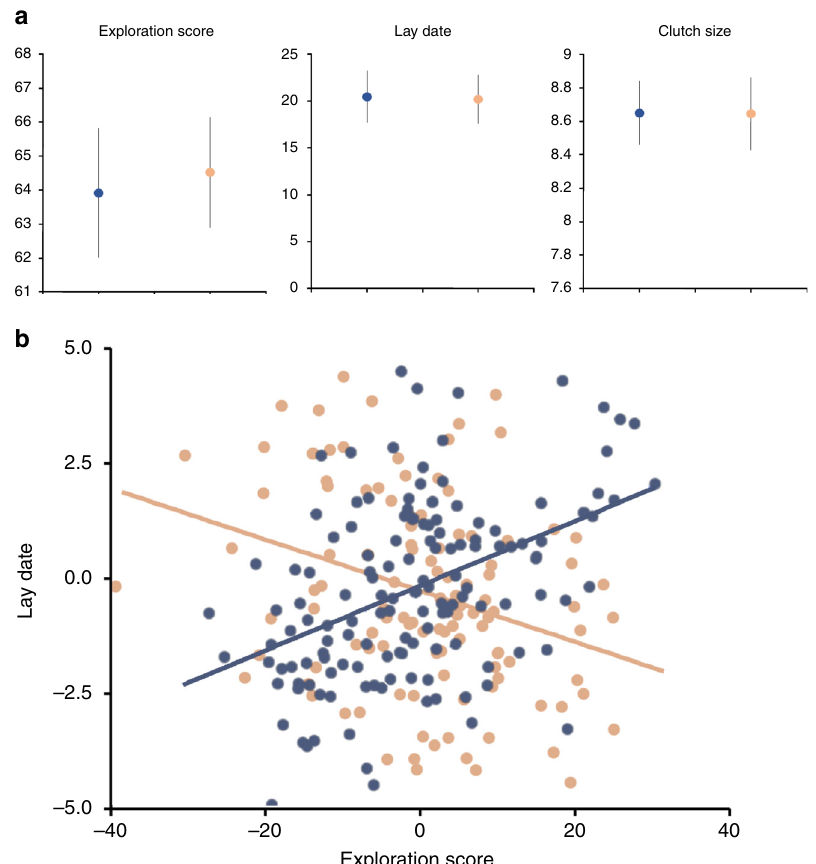
Fig. 2 Responses to perceived predation level (PPL) manipulations. a Differences in traits depending on PPL exposure. Data are means with error bars representing standard error for each unique combination of treatment group and measured trait (exploration score, lay date, clutch size), illustrating the absence of an effect of treatment on mean values detected by our analyses printed in Table 1. Colored dots represent treatment (blue: low PPL: orange: high PPL). b Relationship between exploration score and lay date depending on PPL exposure. Points are individual ’ s best linear unbiased predictors for lay date ( y axis) and exploration score ( x axis). These represent our best estimate of an individual ’ s average value for the two focal traits corrected for the sample size per individual. Colored dots represent treatment (blue: low PPL: orange: high PPL). Source data are provided as a Source Data fi le, total sample size is 326 individuals, 172 in low PPL, 154 in high